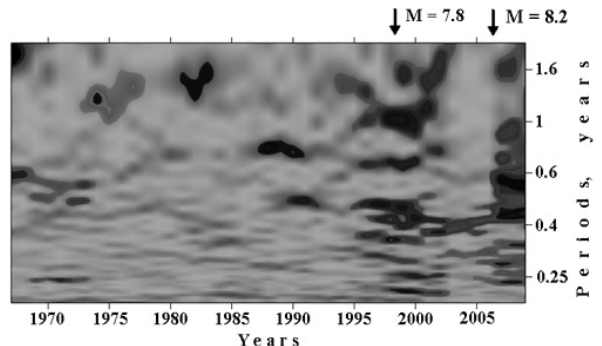
Fig. 13. Spectral-temporal diagram of the logarithmic likelihood function 1 ln L increments for the area with a radius of 50km around the center of the aftershock zone of the Kronotskoe earthquake of 5 December 1997. The ordinates show the spectral periods. The occurrence time of the Kronotskoe earthquake ( M = 7 . 8) is shown by the arrow.